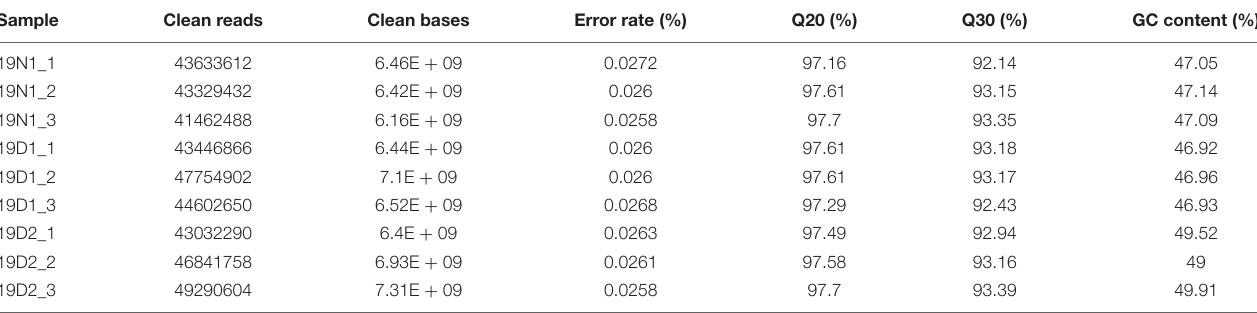
TABLE 1 | Sequencing the Magnolia wufengensis transcriptome from nine apical leaf samples from plants from endodormancy (ED; 19N 1 _1, 19N 1 _2, 19N 1 _3), before ED release (19D